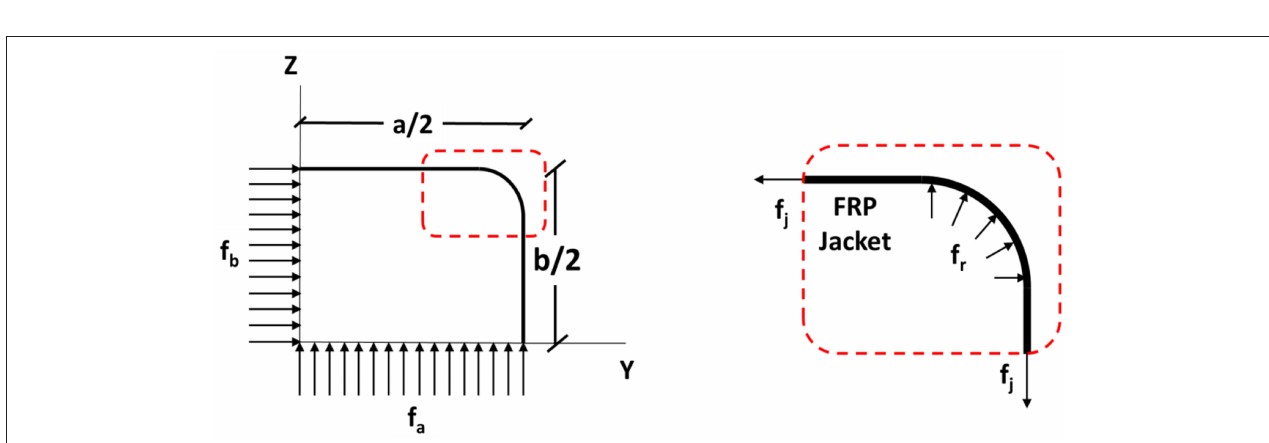
FIGURE 9 | Mechanical behavior for determining the confinement effectiveness factor (Karam and Tabbara, 2005). Hence, the sharper the corner radius is, the higher the confining stress at the corner with respect to the average confining stress inside the cross section. This is supported by finite